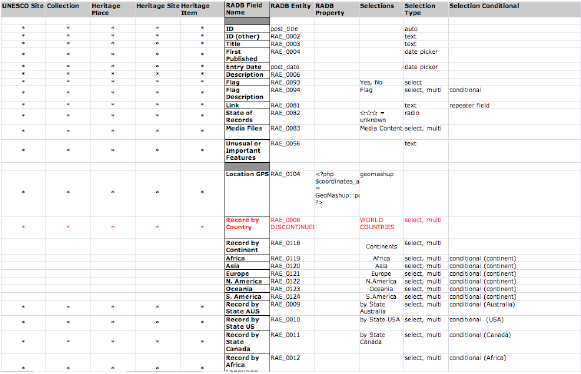
Figure 7. Spreadsheet used to map CIDOC CRM against